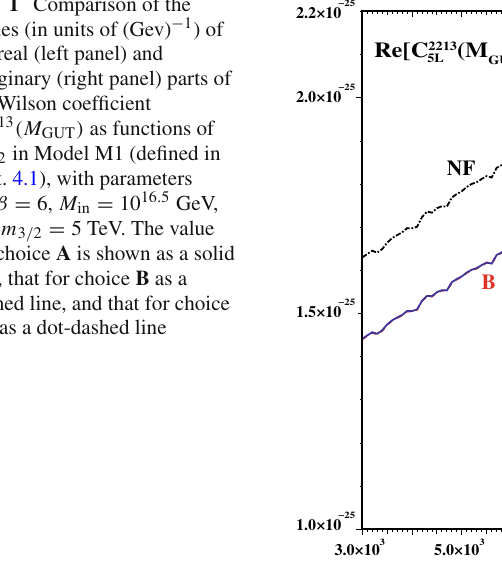
Fig. 1 Comparison of the values (in units of (Gev) − 1 ) of the real (left panel) and imaginary (right panel) parts of the Wilson coefficient ( M ) as functions of C 2213 GUT 5 L m 1 / 2 in Model M1 (defined in Sect. 4.1), with parameters tan β = 6, M in = 10 16 . 5 GeV, and m 3 / 2 = 5 TeV. The value for choice A is shown as a solid line, that for choice B as a dashed line, and that for choice NF as a dot-dashed